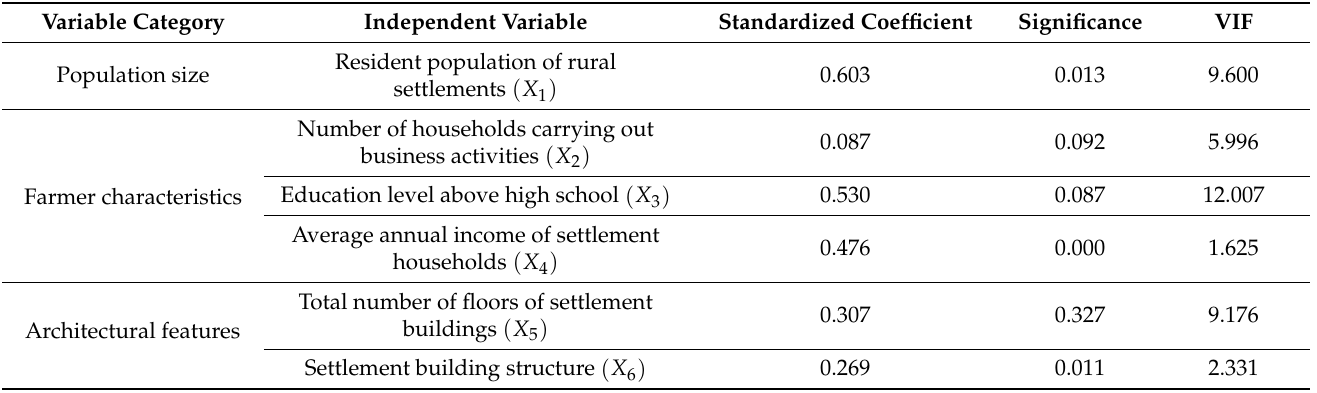
Table 7. Regression coefficient table of MLU levels and socioeconomic